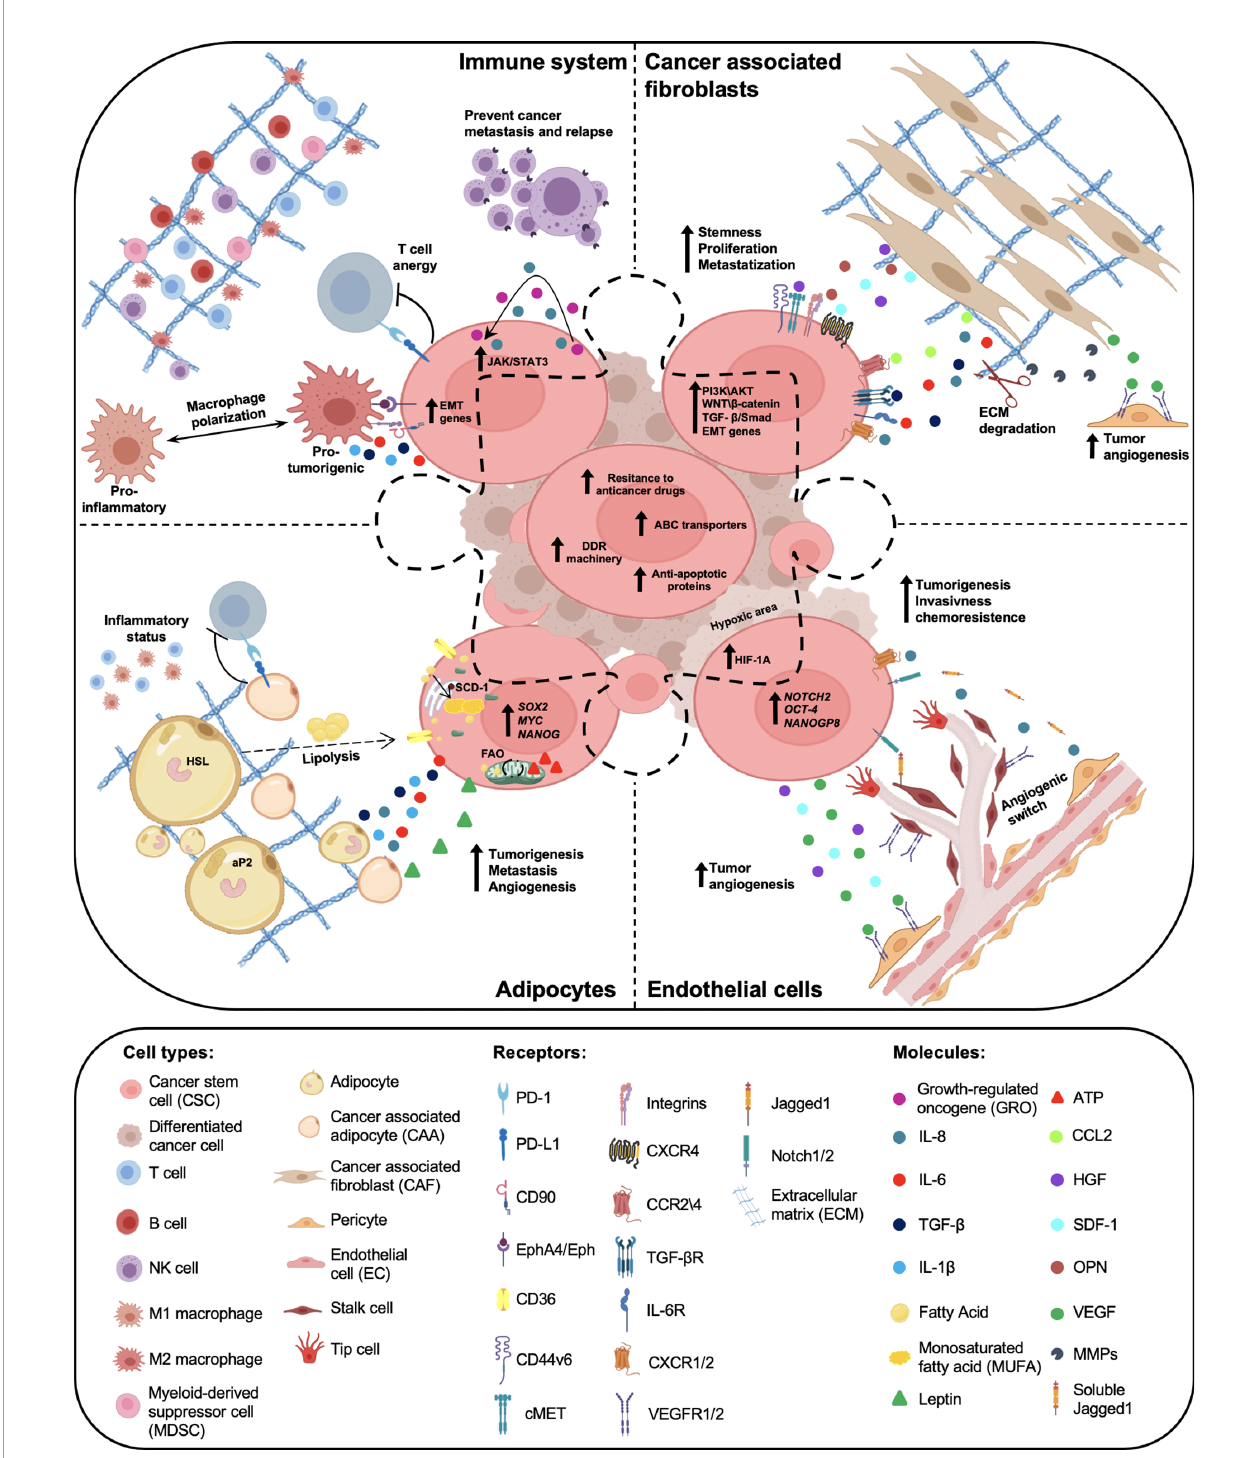
FIGURE 1 | Crosstalk between cancer stem cells (CSCs) and tumor microenvironment (TME) components. Within the tumor mass, a subpopulation of cancer cells, called cancer stem cells (CSCs), are endowed with high resistance to anticancer therapies, due to elevated expression levels of ABC transporters, anti-apoptotic proteins and a pro fi cient DNA damage repair (DDR) machinery. Tumor microenvironment (TME), mainly composed by cancer associated fi broblasts (CAFs), adipocytes, immune and endothelial cells, has a key role in the maintenance of CSC peculiarities. Cytokines and chemokines produced by both CSCs and TME cells boost cancer cell growth, prompt chemoresistance and promote tumor progression and